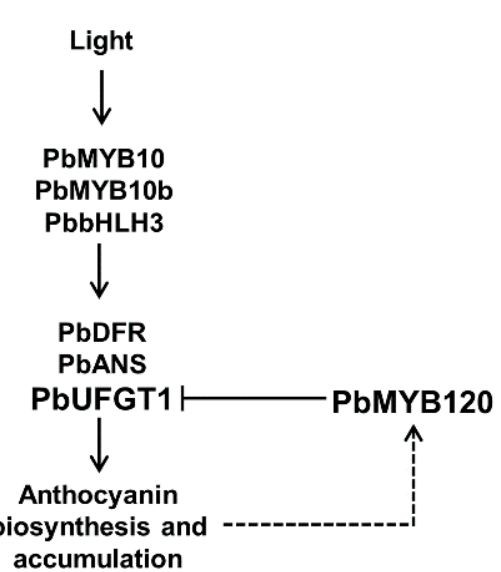
Figure 5. Predicted mechanism of PbMYB120 in the regulation of anthocyanin accumulation. PbMYB120 inhibited anthocyanin biosynthesis by the direct repression of PbUFGT1 . PbMYB120 was expressed in an anthocyanin-dependent manner. PbMYB120 ′ s expression may be induced by light, anthocyanin activators, or increased anthocyanin accumulation. It formed a negative feedback loop regulating anthocyanin accumulation by the direct repression of PbUFGT1 and possible indirect interference with the MYB-bHLH-WD40 (MBW) complex.